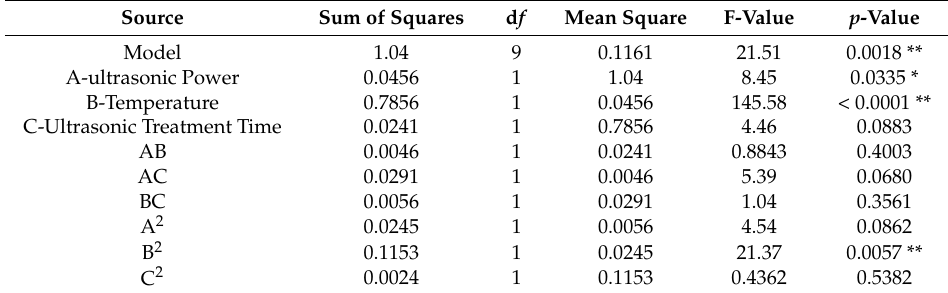
Table 2. Analysis of Variance (ANOVA) for the quadratic model selected from Box–Behnken designs. Source